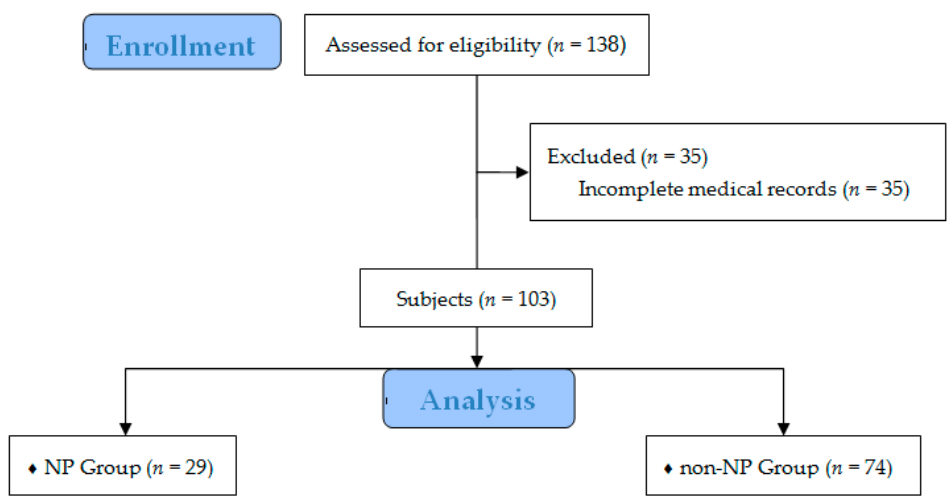
Figure 1. Flow diagram of the study. Abbreviation: NP, neuropathic pain.